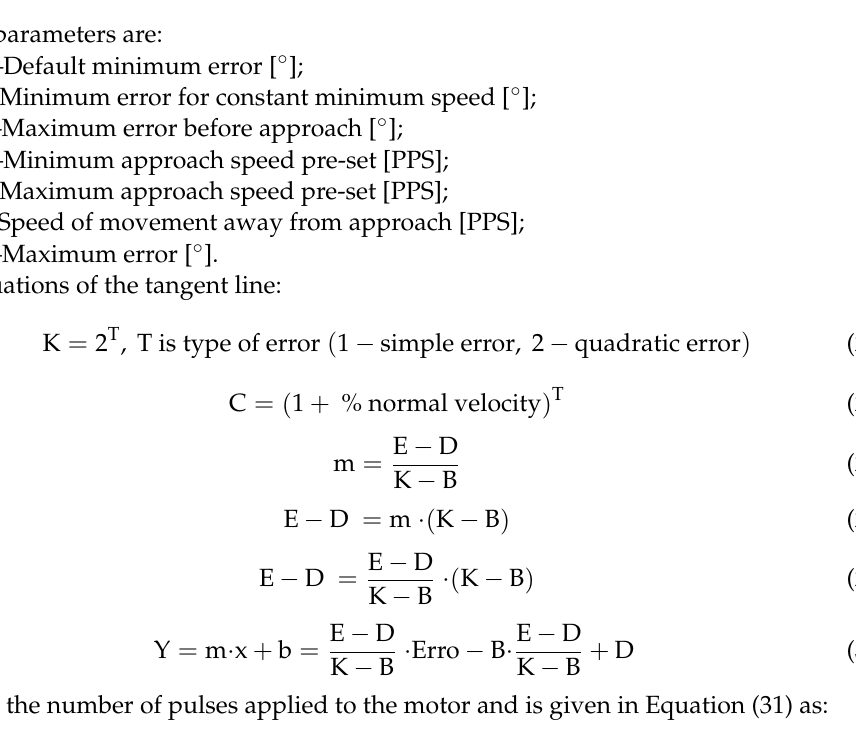
Figure 11. Ramp of number of pulses applied to the motor as a function of error.